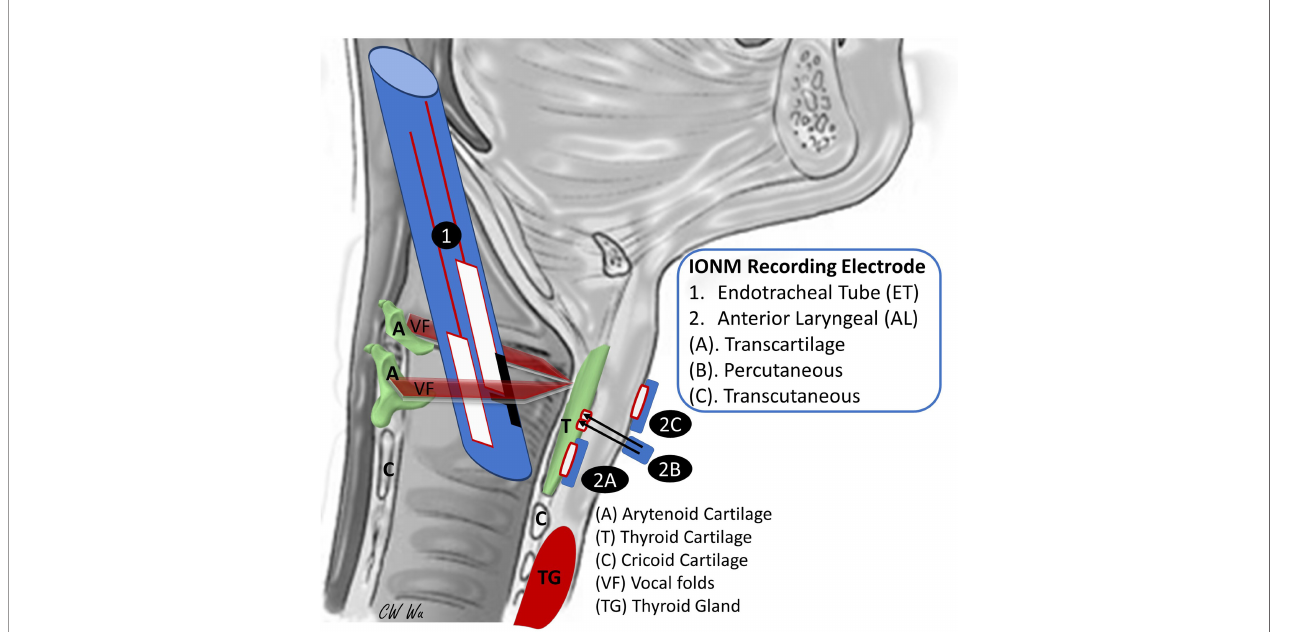
FIGURE 1 | Anatomic relationship between the thyroid cartilage (TC) - vocal folds and intraoperative neural monitoring (IONM) recording electrode placement in different electromyography (EMG) recording techniques used in thyroid and parathyroid surgery. The vocal fold (VF, vocalis and thyroarytenoid muscle) originates from the inner surface of the TC and inserts to the arytenoid cartilage (A). Conventional endotracheal tube (ET) surface electrodes are designed to be placed in contact with vocal folds during intubation for general anesthesia. However, potential displacement of the ET electrode during surgery may affect signal quality and stability. Recent studies have con fi rmed that anterior laryngeal (AL) transcartilage, percutaneous, and transcutaneous surface recording electrodes placed on the TC outer surface also enable access to the EMG response of the vocal folds and can circumvent factors that negatively affect ET electrode